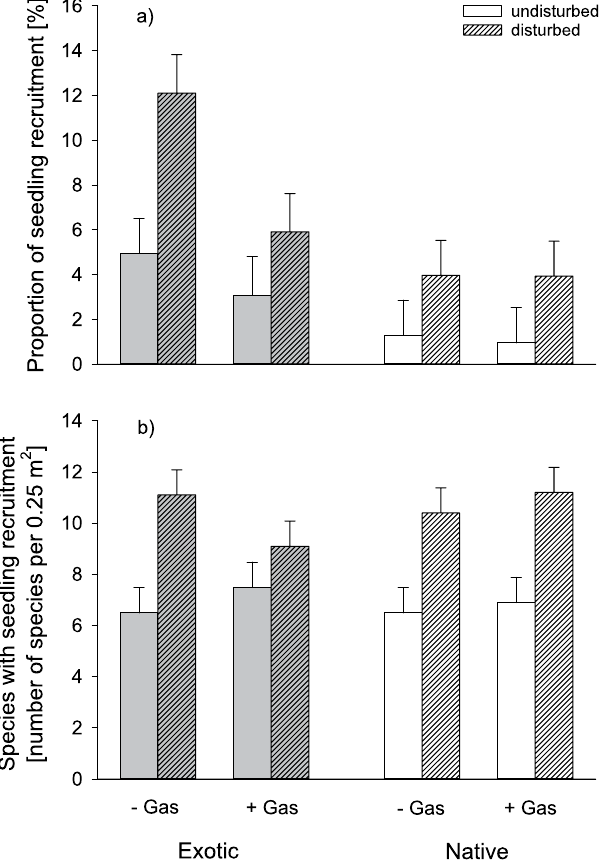
Figure 1. Effect of gastropod herbivory ( + Gas = gastropod control, − Gas = gastropod exclusion), disturbance (disturbed, undisturbed) and species origin (exotic, native) on ( a ) the proportion of seedling recruitment (number of recruited seedlings divided by the number of added seeds) and ( b ) the number of species with seedling recruitment. Note that data shown are the untransformed least square means ± SE of a linear mixed